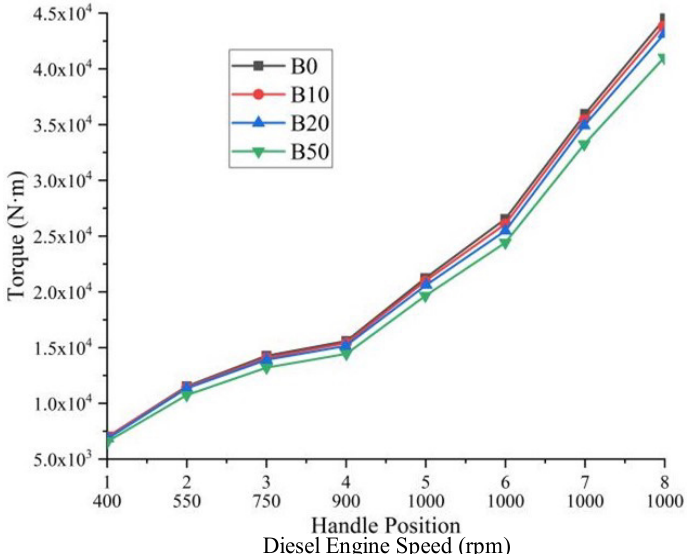
Figure 5. The torque curve of biodiesel with different ratios under various working conditions.